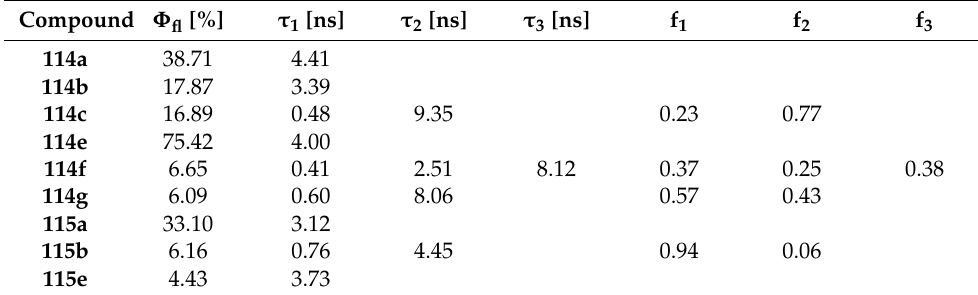
Table 20. Photophysical characteristics of some phenanthroline